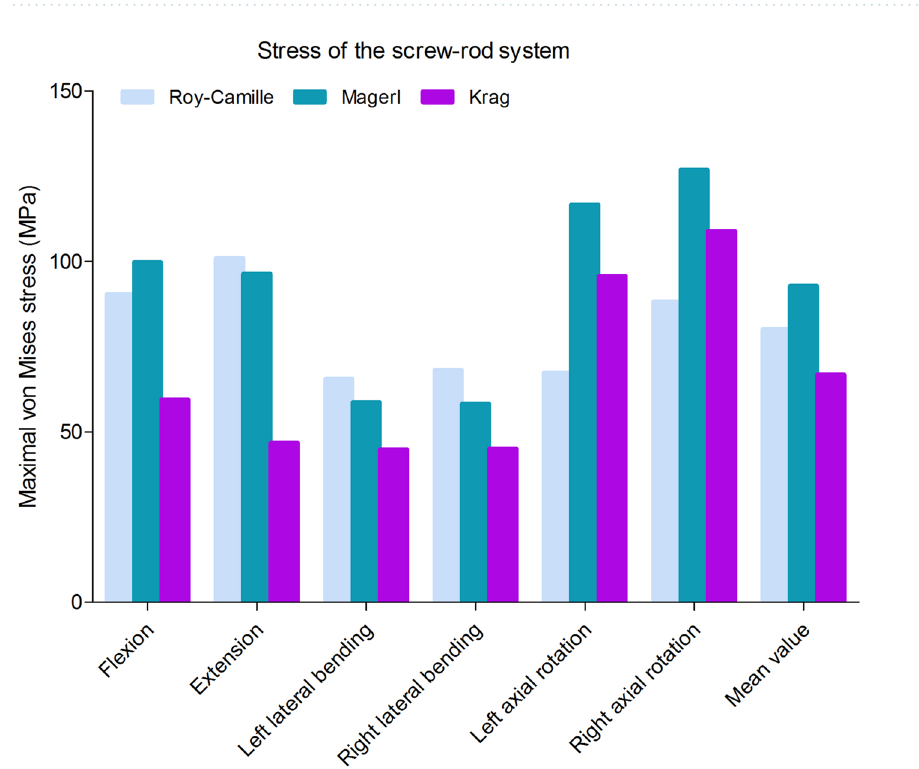
Figure 9. The von Mises stress of the internal fixation in three postoperative FE models under different